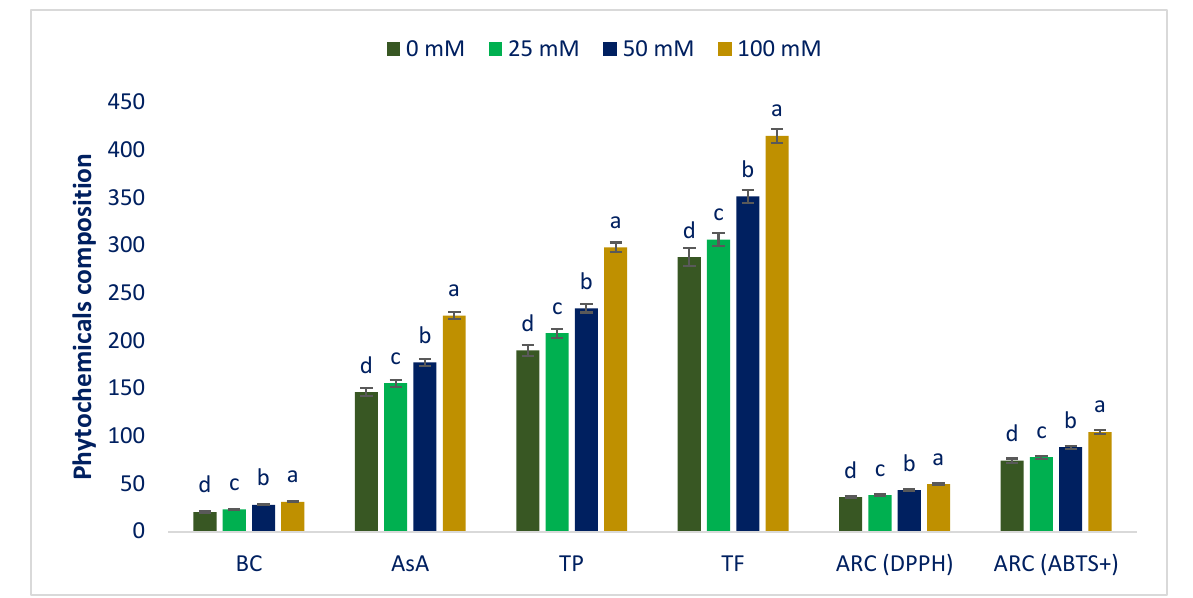
Figure 7. Response of phytochemical composition of Lalshak under salt stress ( n = 6). Dissimilar letters in the bars varied significantly by DMRT ( p < 0.01).